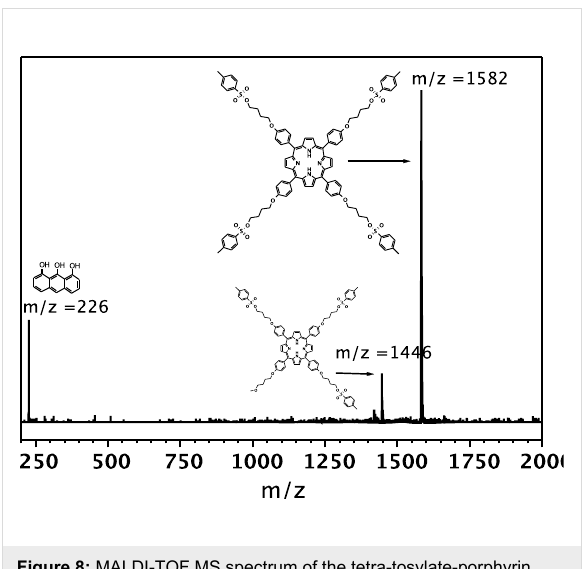
Figure 8: MALDI-TOF MS spectrum of the tetra-tosylate-porphyrin (TetraTos-B). Matrix: dithranol.